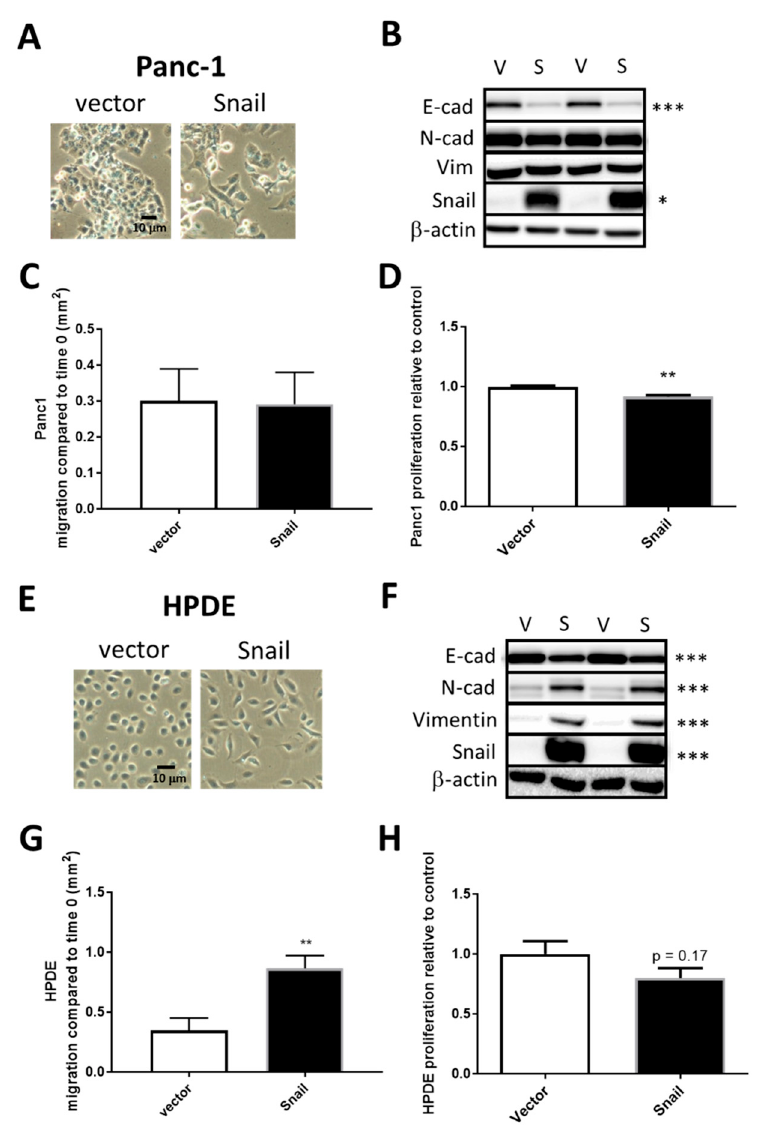
Figure 2. Snail overexpression induced EMT in Panc1 ( A – D ) and HPDE ( E – H ) cells. Vector control (V) and Snail-overexpressing (S) cells were generated in Panc1 via retroviral-mediated infections. ( A , E ) Representative cell images were taken under bright field microscopy. ( B , F ) Cell lysates were resolved by SDS-PAGE and immunoblotted with anti-E-cad, anti-N-cad, anti-vimentin, and anti-Snail antibodies with β -actin used as a loading control. ( C , G ) Cell migration as measured by wound healing assay. ( D , H ) Cell proliferation as measured by crystal violet assay. Results are shown as mean ± SEM with n = 3. * p < 0.05, ** p < 0.01, *** p < 0.001 for di ff erence between vector control and Snail-overexpressing cells.